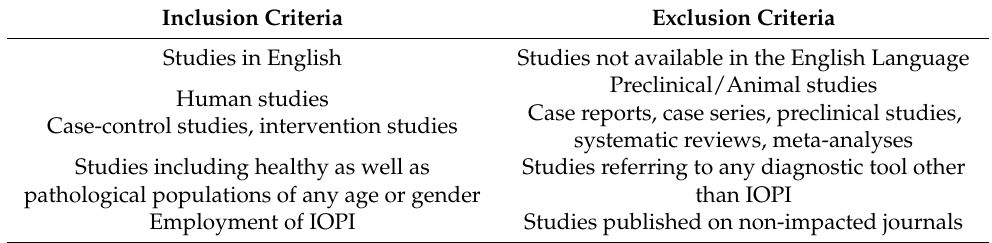
Table 1. Inclusion/exclusion